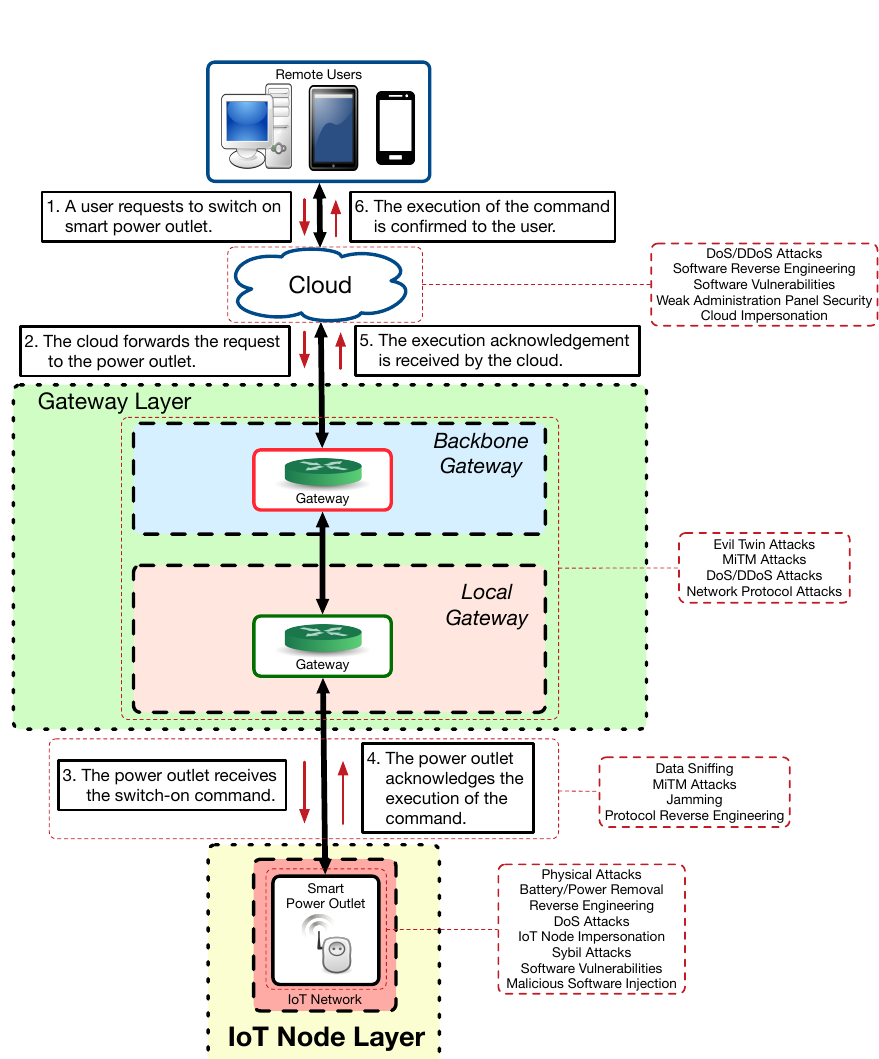
Figure 3. Switching on an IoT-enabled power outlet using a cloud-based